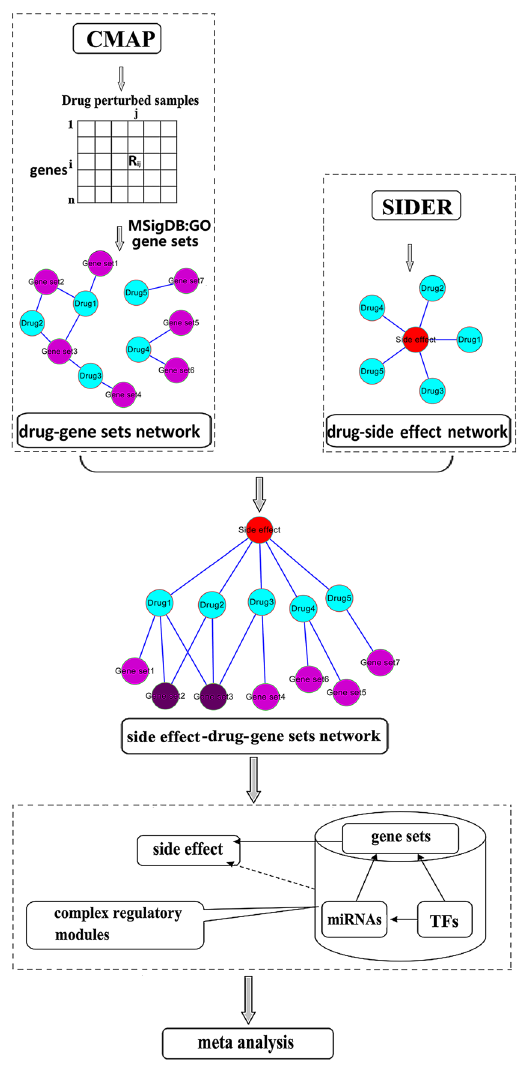
Figure 1. The specific work flow. The red nodes represent side effects, the cyan nodes represent drug, the purple nodes represent gene sets, the deep purple nodes represent side effect-related gene sets. Firstly, we enriched the drug related genes to GO gene sets to establish drug-gene sets network. Secondly, in term of the drug-side effect network and drug-gene sets network, we built a side effect -drug-gene sets network and identified the significant side effect-gene set pairs. Thirdly, we set up a side effect-gene sets-miRNA(TF)composite network after enriching the gene sets to the miRNA(TF). Finally, we extracted composite regulatory modules including four regulated patterns of all side effects from the directed regulated network composed of gene set, miRNA and TF. And took Pneumonia and Neutropenia as example for comprehensively interpreting occurrence mechanism of side